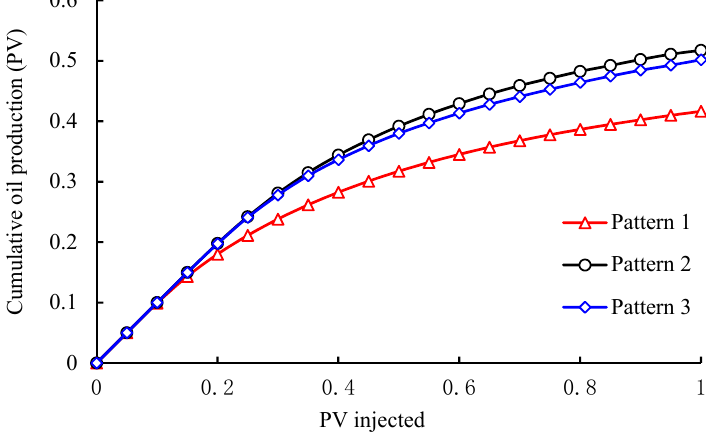
ff erent fracture length patterns.